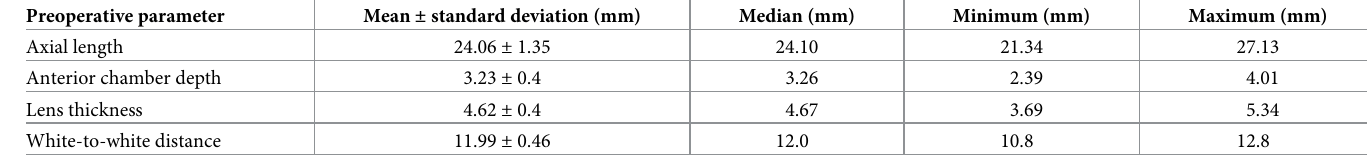
Table 1. Preoperative morphologic parameters in 52 eyes undergoing low-energy Femtosecond-Laser-Assisted Cataract Surgery (FLACS).